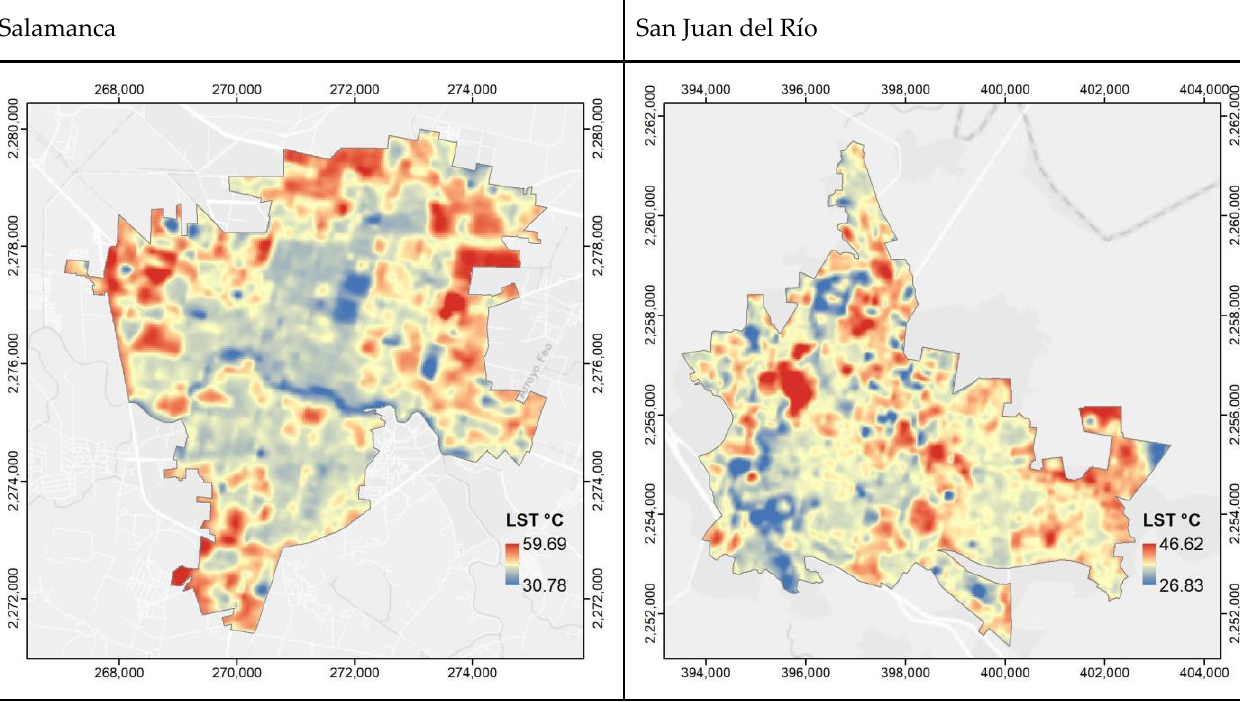
Figure A1. Landsat Daytime Land Surface Temperature of Ten Metropolitan Cities and Four Conurbations in May 2020, with SUN code..